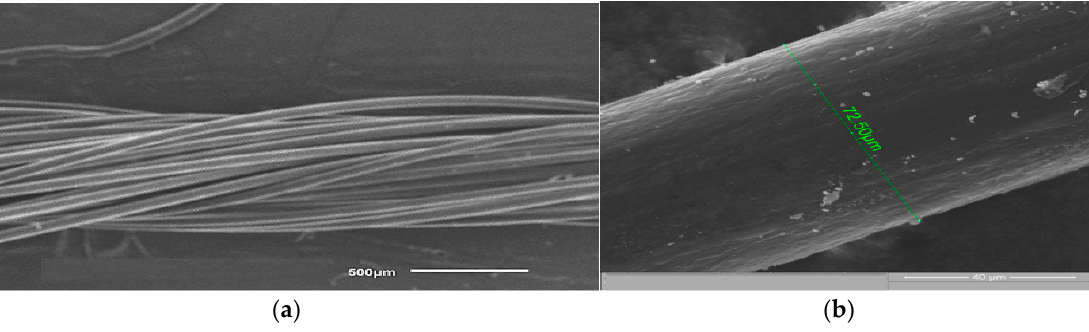
Figure 6. SEM images of Vestamid fibres. ( a ) Displays the NRG 6001 multifilament fibres and ( b ) a single NRG 6001 fibre.